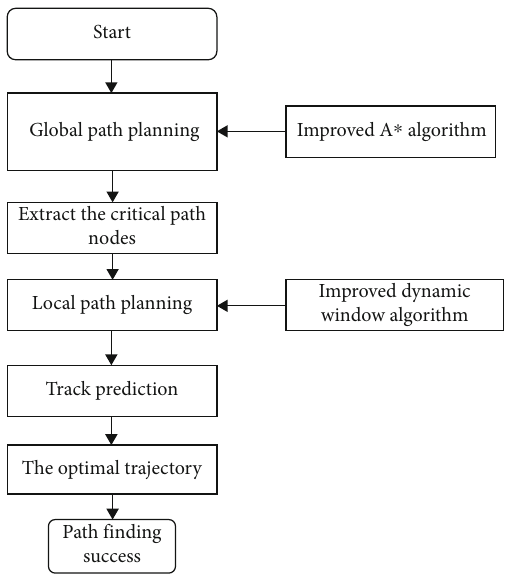
Figure 8: The fusion algorithm ’ s fl owchart.